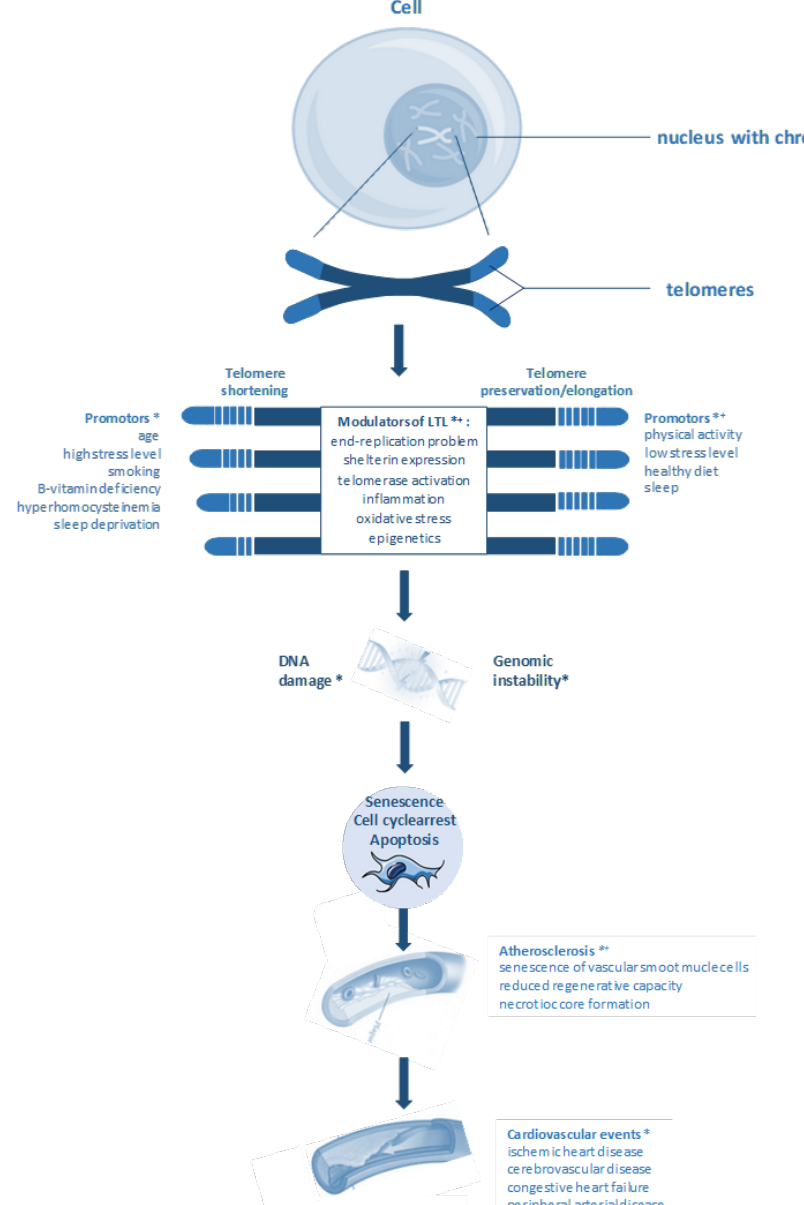
Figure 1. Telomere shortening causes genomic instability, which (1) triggers cell-cycle arrest, senescence, and apoptosis of vascular smooth muscle cells, (2) reduces the regenerative capacity of blood vessel tissue, and (3) promotes the formation of a necrotic core in atherosclerotic plaques. Ultimately, this increases the risk of cardiovascular events. Telomere length could be preserved through lifestyle interventions, such as regular physical activity, low-stress levels, healthy diet, and sleeping patterns. * supported by correlation studies , + supported by functional studies in vivo or in vitro.